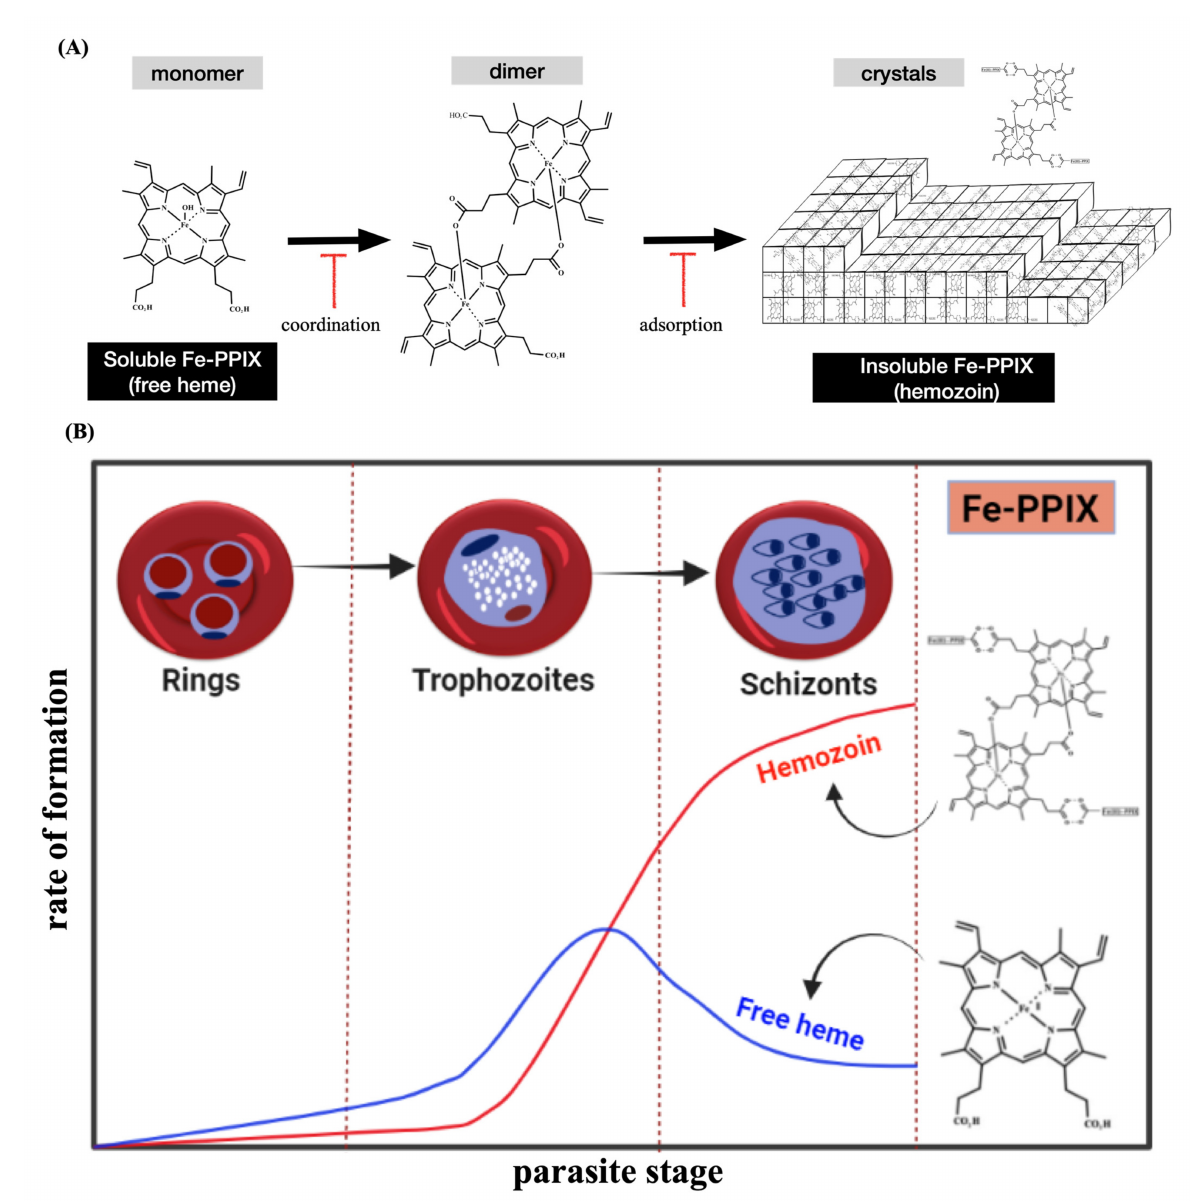
Figure 2. Overview of the heme detoxification process. Panel ( A ) shows that this process is centered on the conversion of soluble Fe-PPIX into insoluble Hz crystals. Antimalarials can typically block this process by binding, via iron coordination chemistry, to soluble Fe-PPIX and by capping the surface of Hz crystals via adsorption mechanisms. Panel ( B ) shows that the phenotype of heme detoxification within the asexual blood stage of Plasmodium , characterized by a decline in the levels of soluble heme (free heme) and a sharp rise in Hz